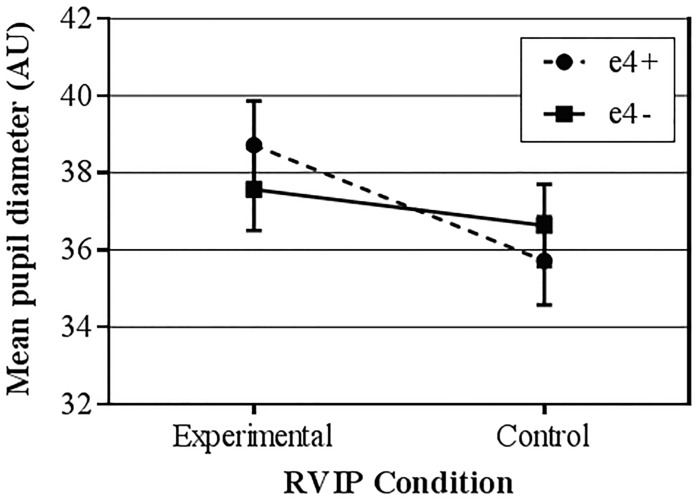
Mean pupil diameter by RVIP condition separated by genotype.Error bars represent the standard error; units are arbitrary.